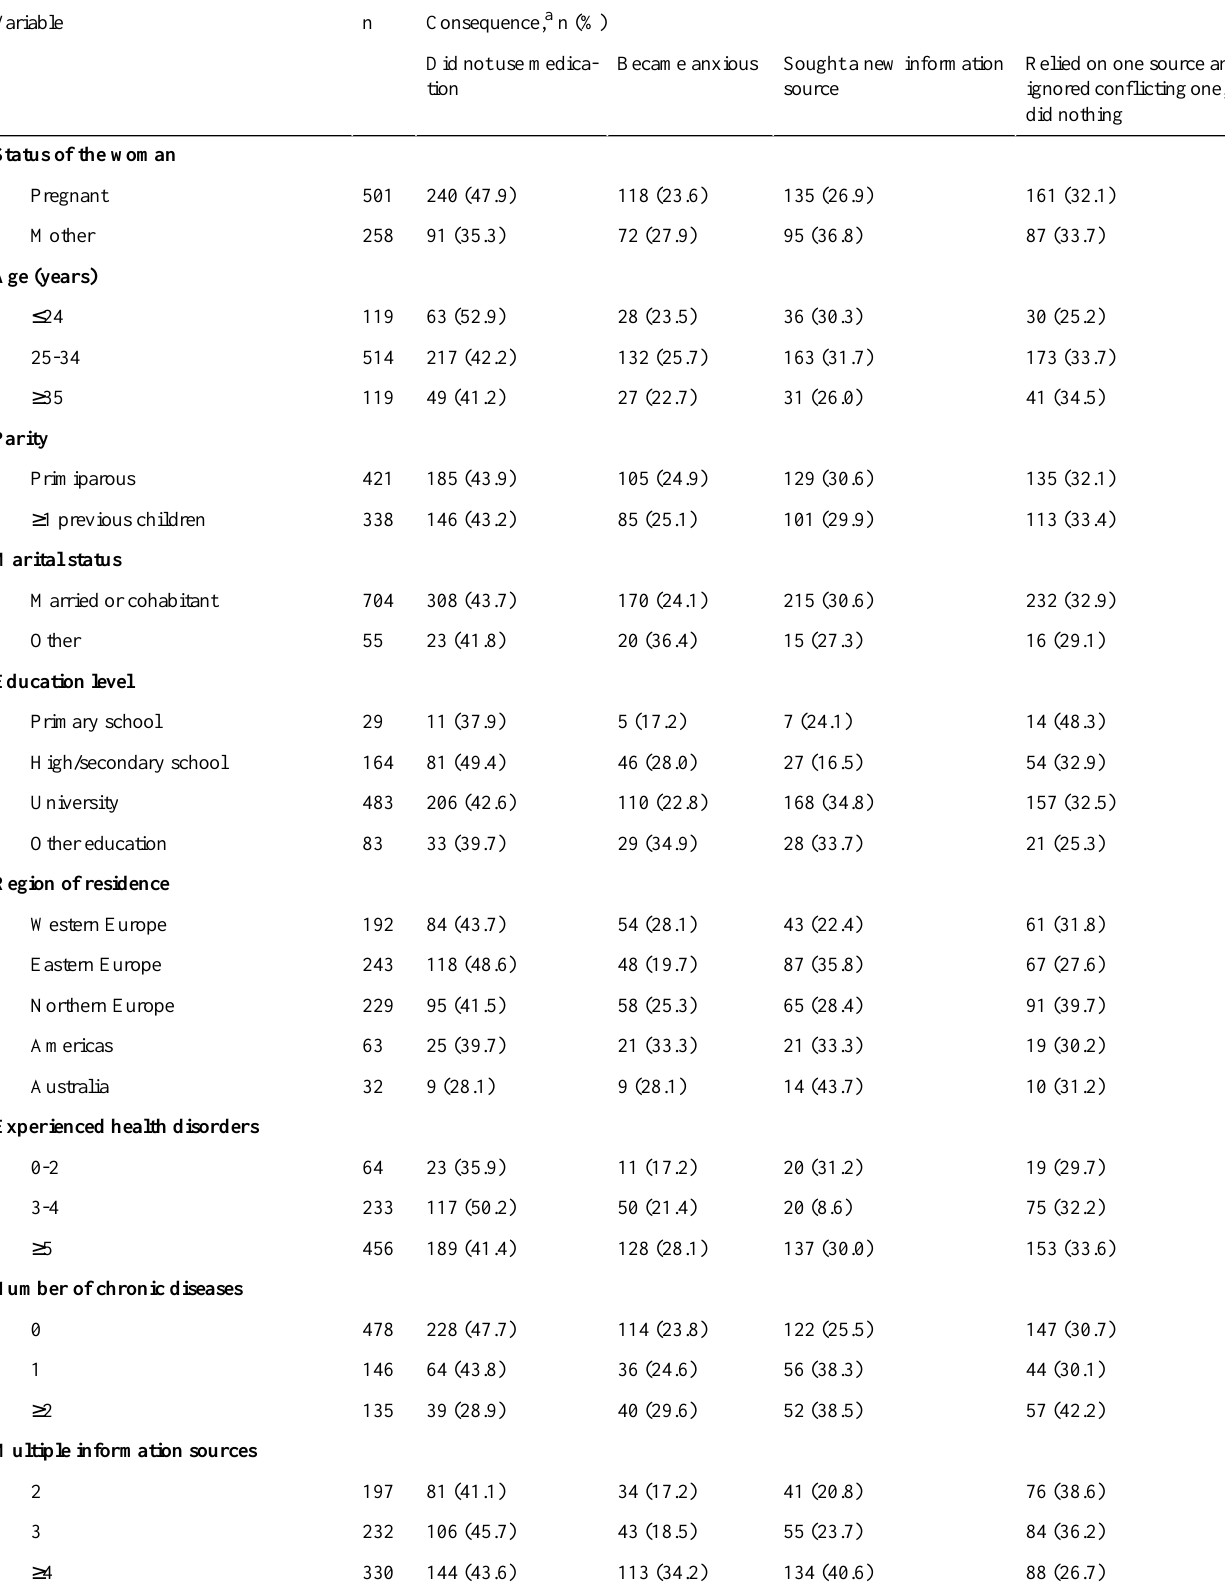
Table 2. Consequences of discrepancies between different information sources by background variables